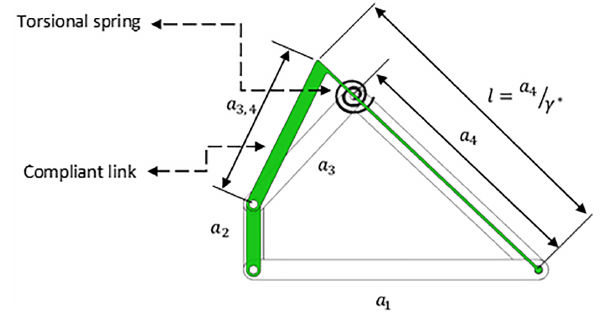
Figure 8. Rigid-body-replacement